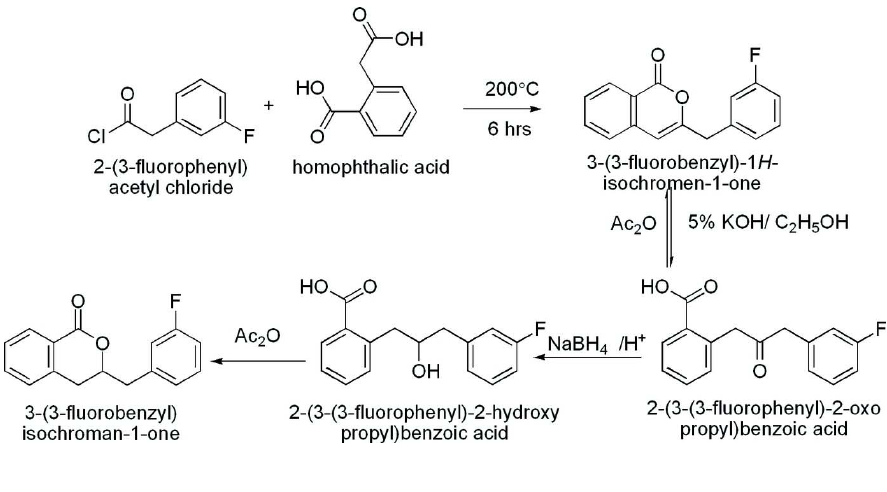
Figure 2 The formation of the title